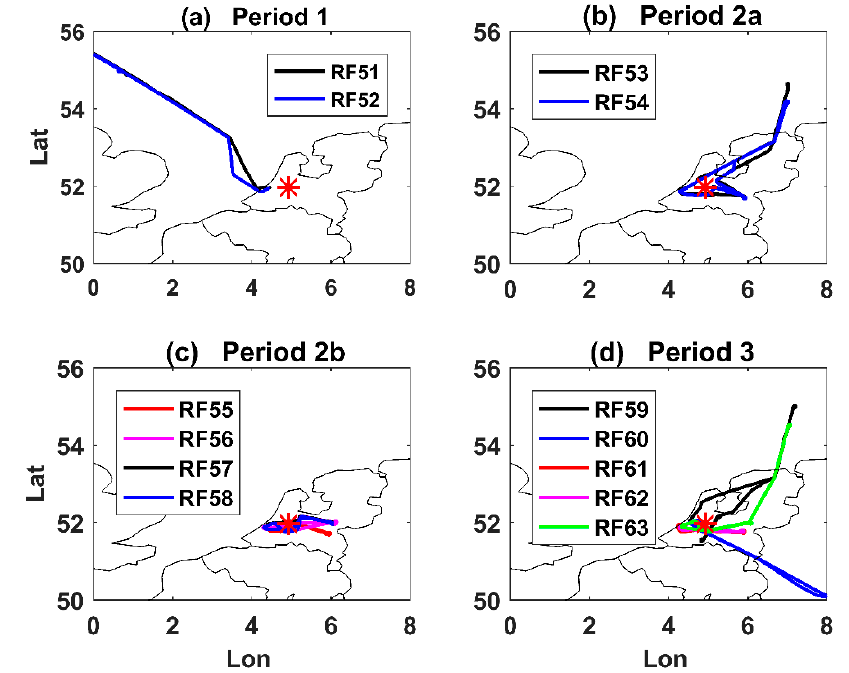
Figure 2. The ATR-42 research flight tracks of for period ( a ) 1, ( b ) 2a, ( c ) 2b, and ( d ) 3 used in this study, the red star indicates Cabauw supersite. Refer to the main text (Section 4.4) for a detailed description of the periods.